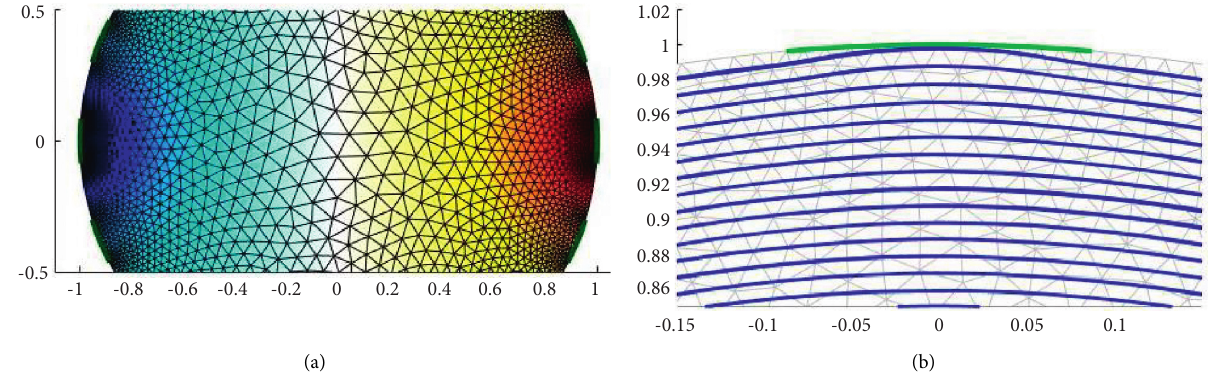
Figure 9: Excitation sensitive field potential diagram. (a) The electric field distribution map; (b) the local electrode potential line distribution